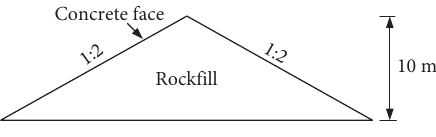
Figure 16: Geometry model of a simple